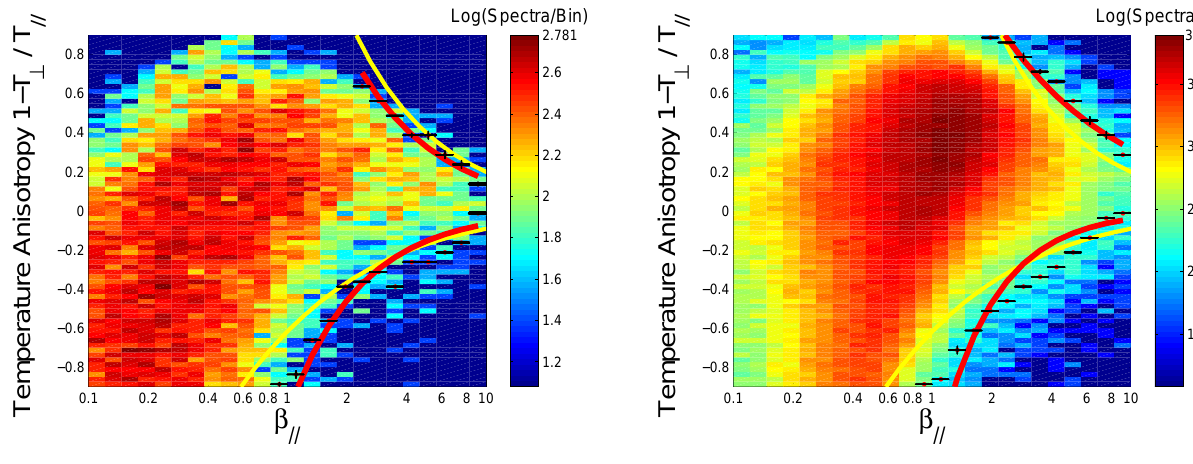
Fig. 2. Two-dimensional histogram of the solar wind proton anisotropy as measured within two radial distance ranges, R ≤ 0 . 4AU (left frame) and R> 0 . 4AU (right frame). The core temperature anisotropy, A = 1 − T ⊥ /T k , is shown as a function of the parallel plasma β k of the core protons. The colour coding logarithmically indicates the number of spectra per bin. The color scale itself is linear. Black horizontal bars in each β k -column indicate where the logarithm of the number of spectra equals 1.6 (2.2 in the right frame), which is used as a limiting value. The red lines are theoretical fits to these data points. The total number of proton spectra is 24856 (left), respectively, 193902